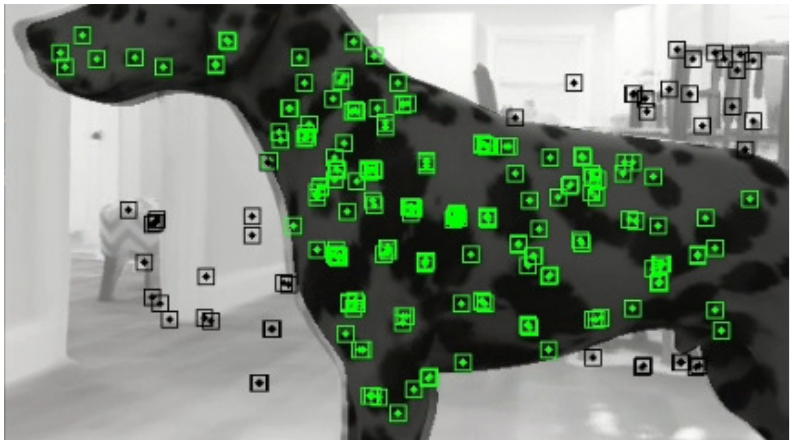
Figure 4. A moving object (Dalmatian dog) covers most of the